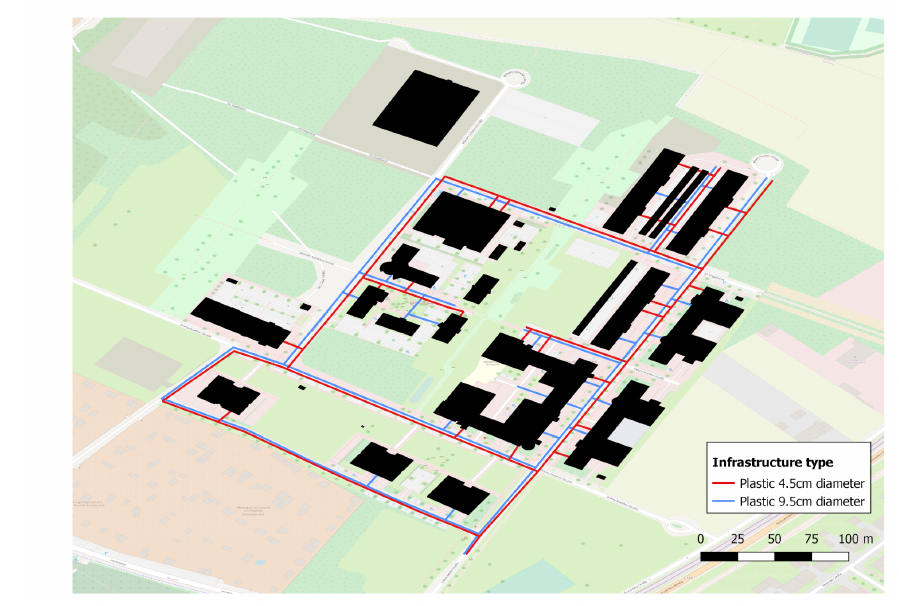
Figure 5. Spatial extent of the study area with data curated from OpenStreetMap and a utility network in the CityGML Utility Network ADE